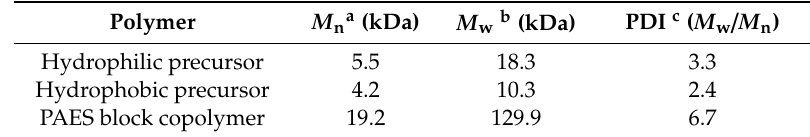
Table 1. Molecular weight and PDI of